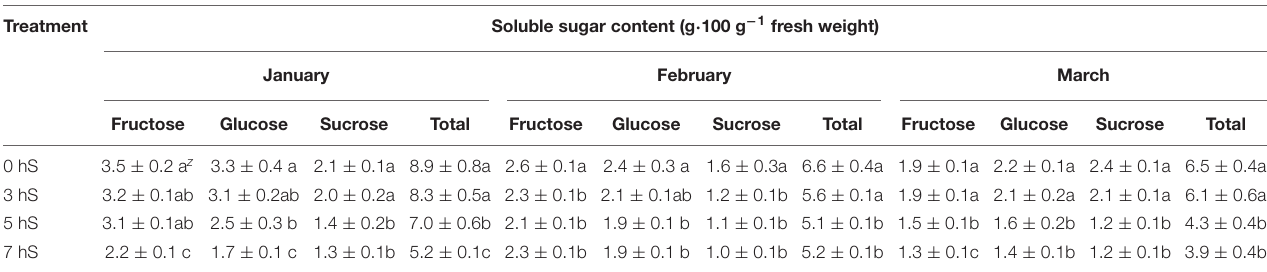
TABLE 3 | Soluble sugar contents of strawberry ( Fragaria × ananassa ) fruit grown under various light intensity conditions in a smart greenhouse. Treatment